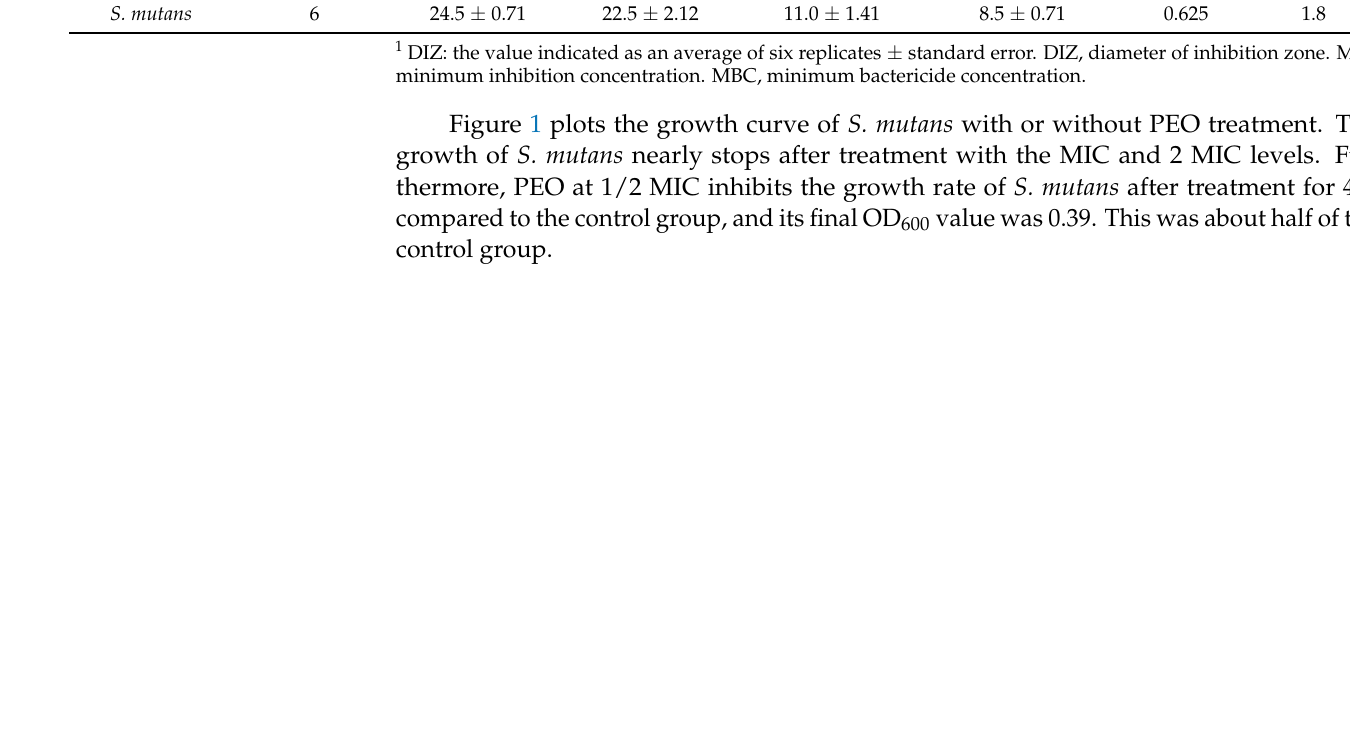
Table 2. The DIZ, MIC and MBC of PEO against S. mutans .